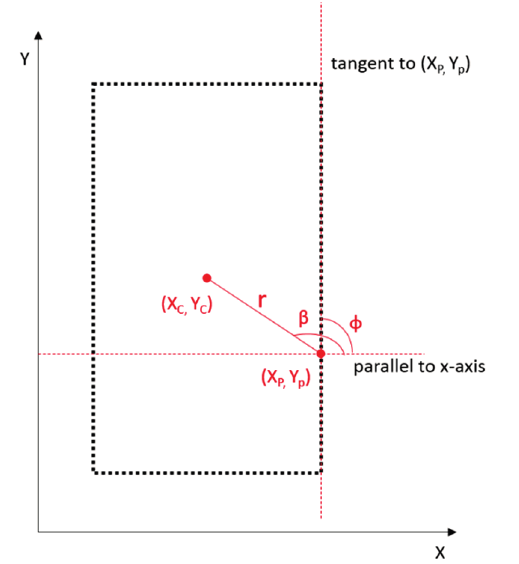
Figure 10. Parameters involved in the GHT for door-candidate